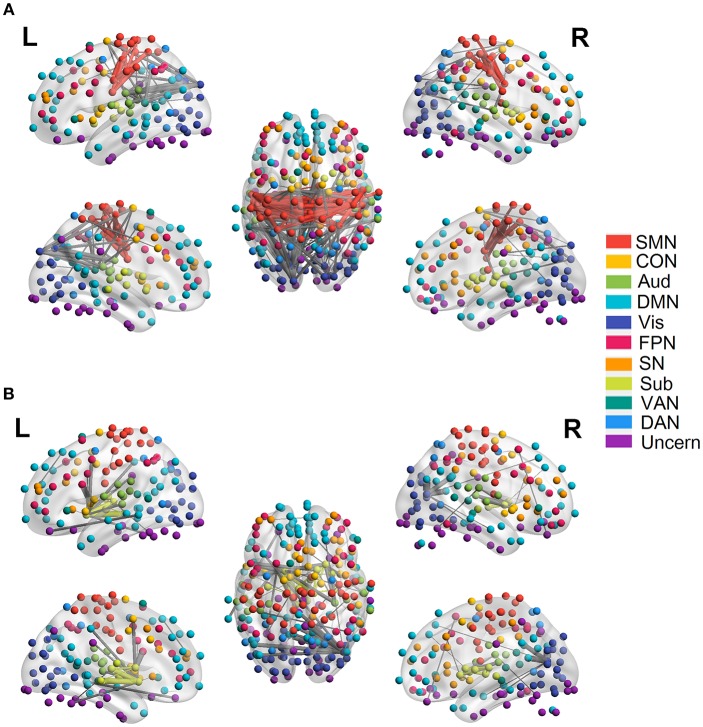
Quadratic relationship between functional connectivity and age at the edge level (p < 0.0001, FDR corrected). (A) Significant edges showing negative quadratic changes with age. (B) Significant edges showing positive quadratic changes with age. Different color refers to different networks. If two nodes of the edge have same color, that is, they belong to the same network, the edge will be set as the same color. Otherwise the edge will be colored gray. The edge size is scaled by its T-statistics.